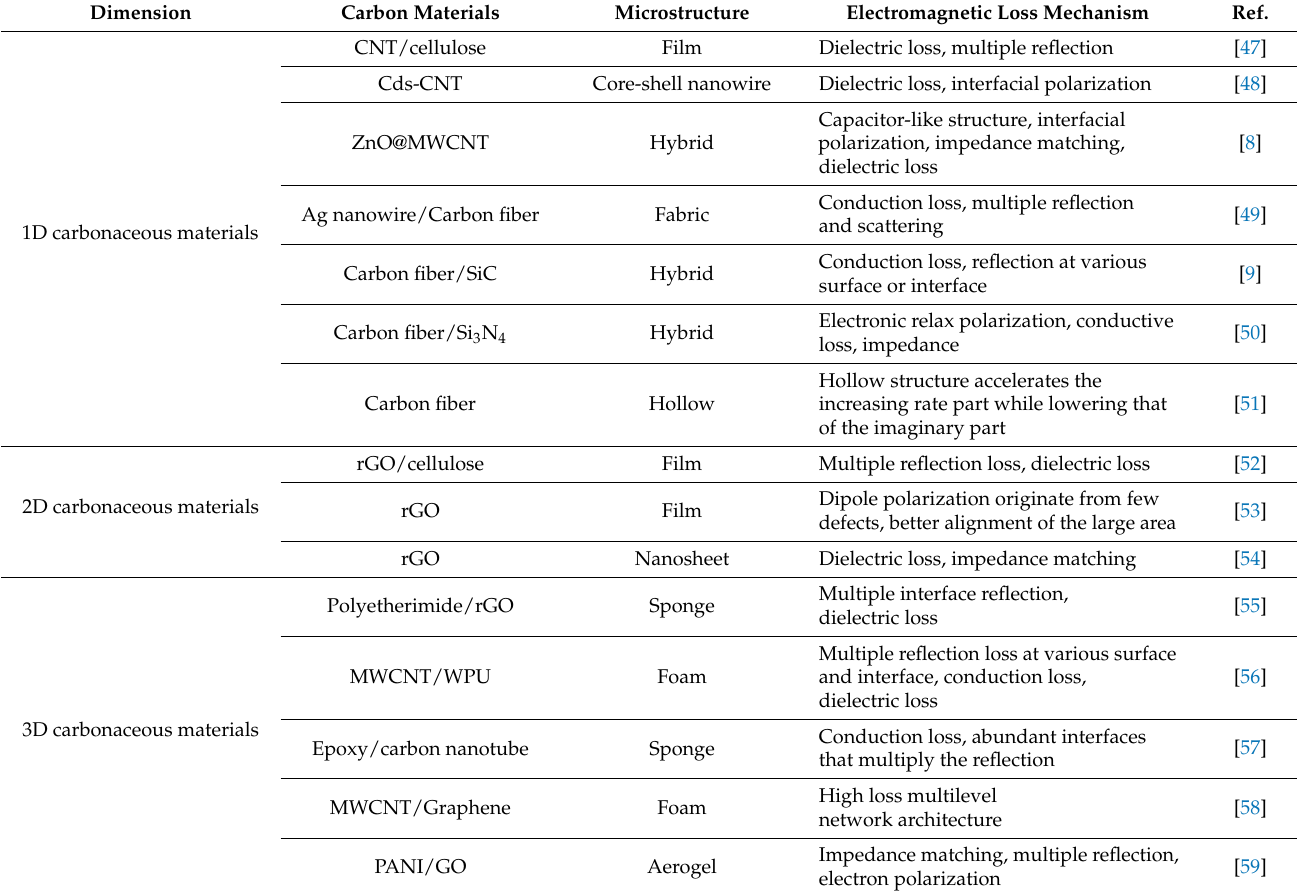
Table 1. The EM loss mechanisms of different dimensional carbon